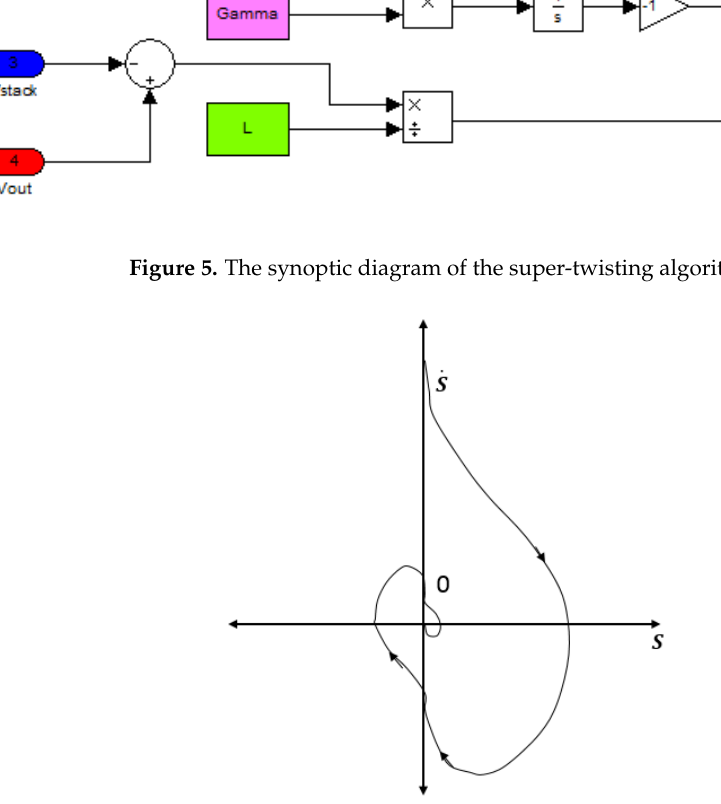
Figure 6. Super-twisting algorithm phase